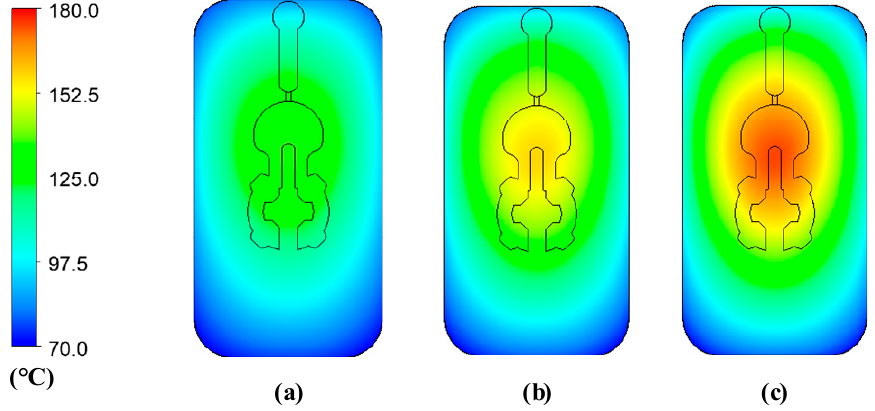
Figure 10. Temperature distribution of the molding area with an initial temperature of 30 °C; a gas temperature of 300 °C; a heating time of 20 s; and a stamp thickness of ( a ) 2.1 mm, ( b ) 1.6 mm, and ( c ) 1.1 mm.